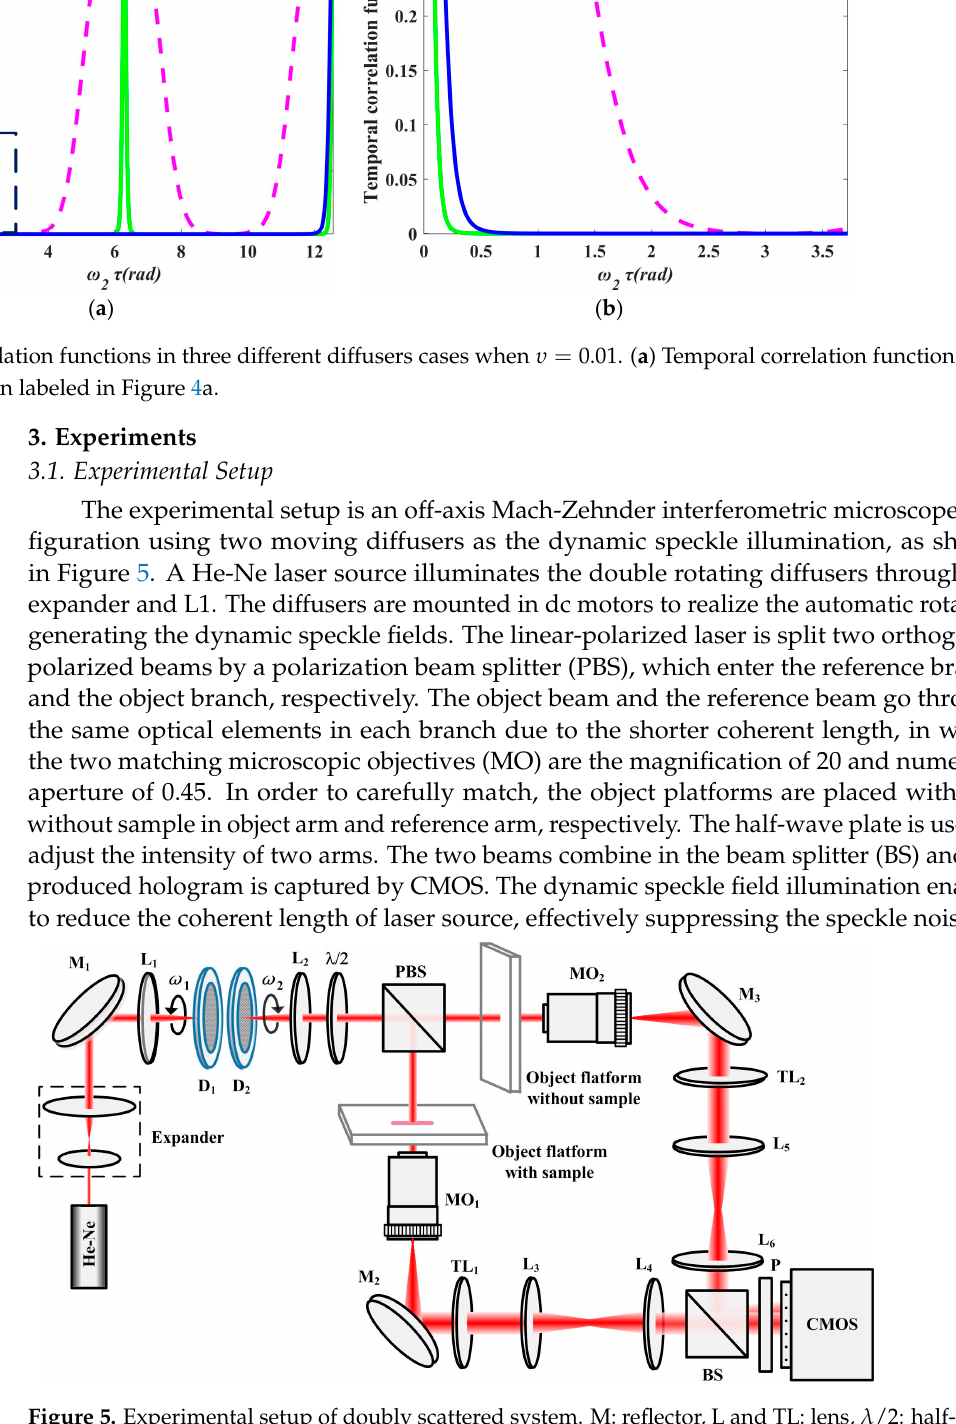
Figure 5. Experimental setup of doubly scattered system. M: reflector, L and TL: lens, λ /2: half-wave plate, D: diffuser, PBS: polarization beam splitter, MO: microscopic objective, BS: beam splitter, P: polarizer.